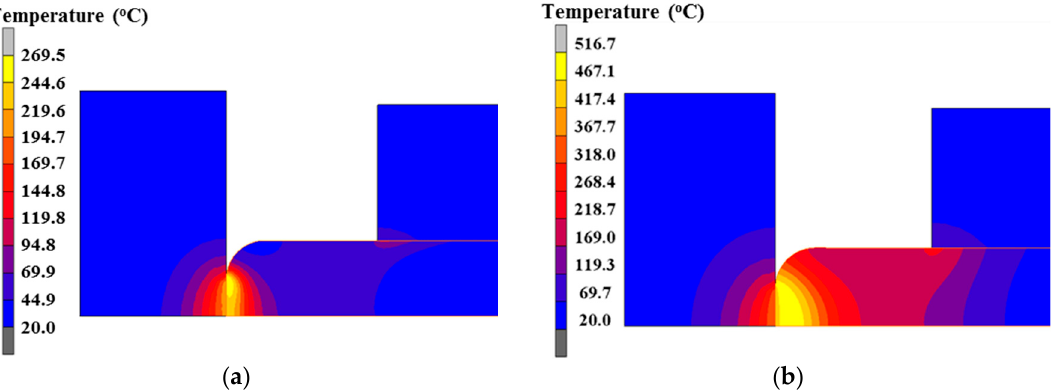
Figure 7. Temperature field at different moments during the preheating process: ( a ) at 5th second and ( b ) at the end moment of the preheating process.